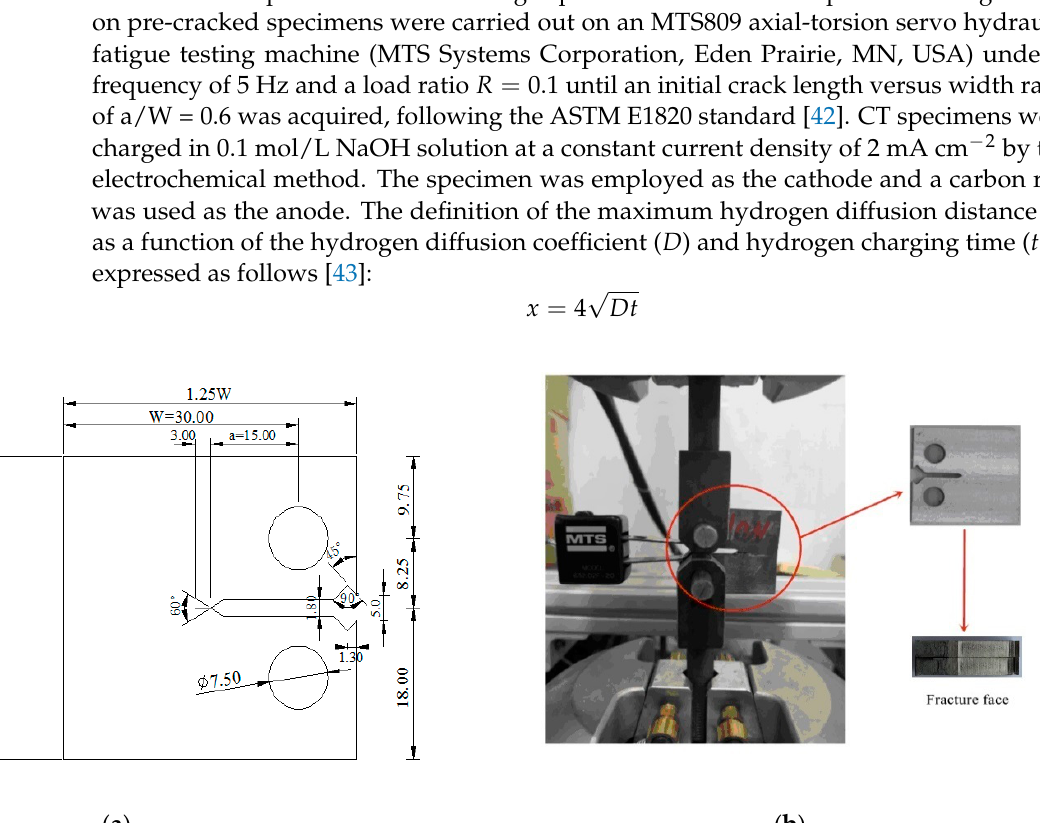
Figure 1. ( a ) Microstructure of the tested specimen and ( b ) experimental stress-strain curve obtained from the uniaxial tests.